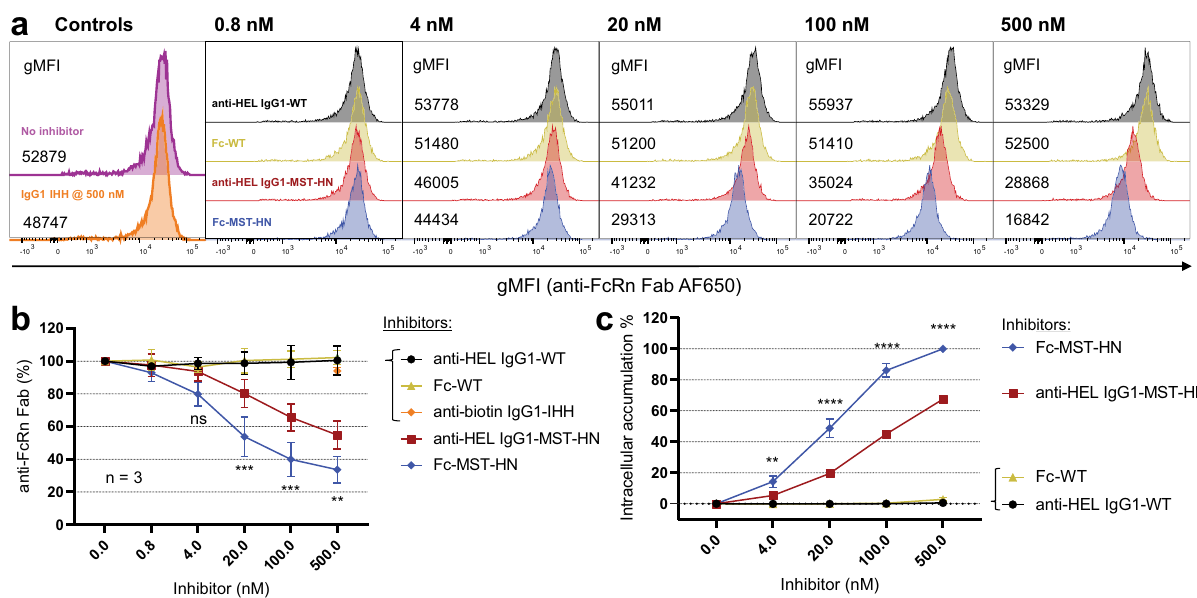
Fig. 4 | Fc-MST-HN shows higher levels of intracellular FcRn occupancy com- paredwithIgG1-MST-HN.a Histogramsofarepresentativeexperimentcomparing thebindingofAF650-labeledanti-FcRnFabtoFcRninHEK-FcRn-GFPcellsafterpre- loadingcellswithindicatedIgGvariantsat37°Cfor2handsubsequentlyremoving surface-bound IgG by extensive washing. b Anti-FcRn Fab-AF650 staining of cells plotted as percent gMFI in the presence of indicated inhibitors compared with untreatedcells. c Intracellular accumulationof equally AF405-labeled molecules in HEK-FcRn-GFP cells after pre-loading and washing the cells as in ( a ) as measured